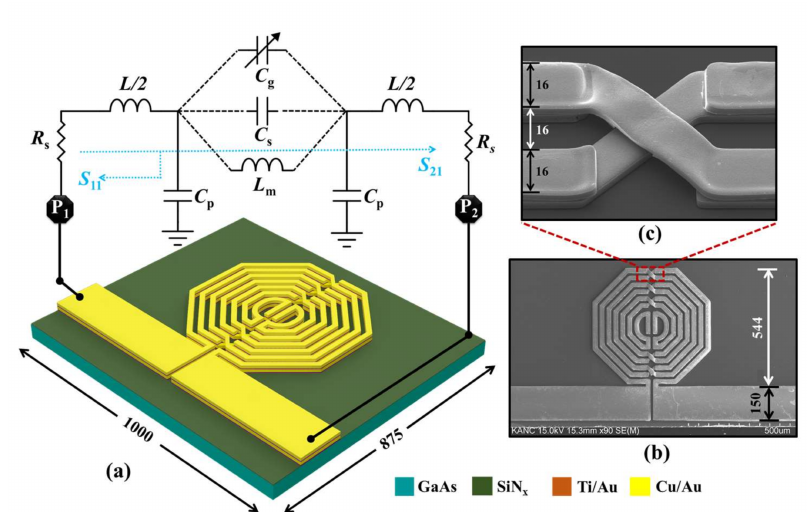
Figure 1. Schematic diagram of the proposed sensor. ( a ) The multilayered spiral-coupled octagonal resonator structure realized through IPD processing has a total size of 1 mm × 0.875 mm, shown with its equivalent lumped-element circuit; ( b ) Scanning electron microscopy (SEM) image of the fabricated sensor; ( c ) An enlarged view of the air-bridge interconnection. (Note: all dimensional units are in